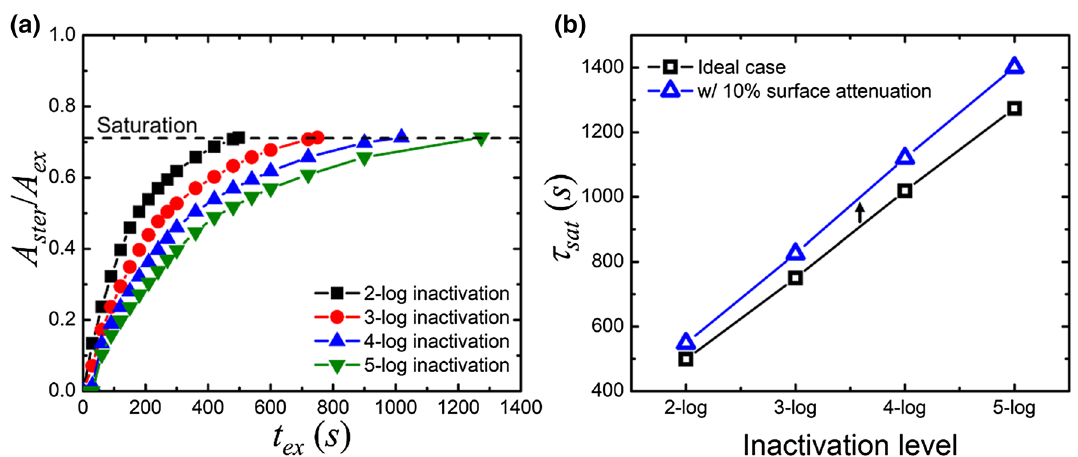
Figure 7. ( a ) Under different inactivation levels from 2-log to 5-log, A ster / A ex is a function of exposure time. A ster / A ex increases and gradually saturates around 0.71 where the exposure time is defined as saturation time τ sat . ( b ) The effect of surface attenuation of UV-C radiation on the saturation time τ sat is shown for inactivation levels from 2-log to